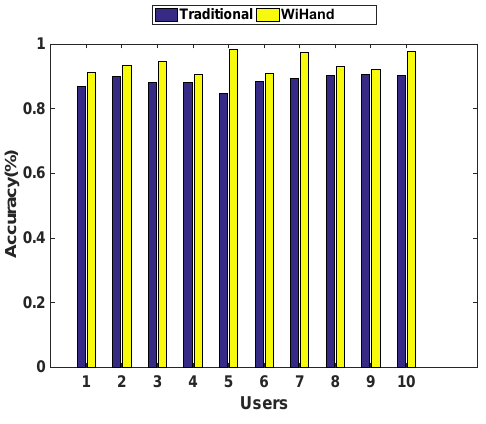
Figure 11. The average accuracy of gesture detection for each